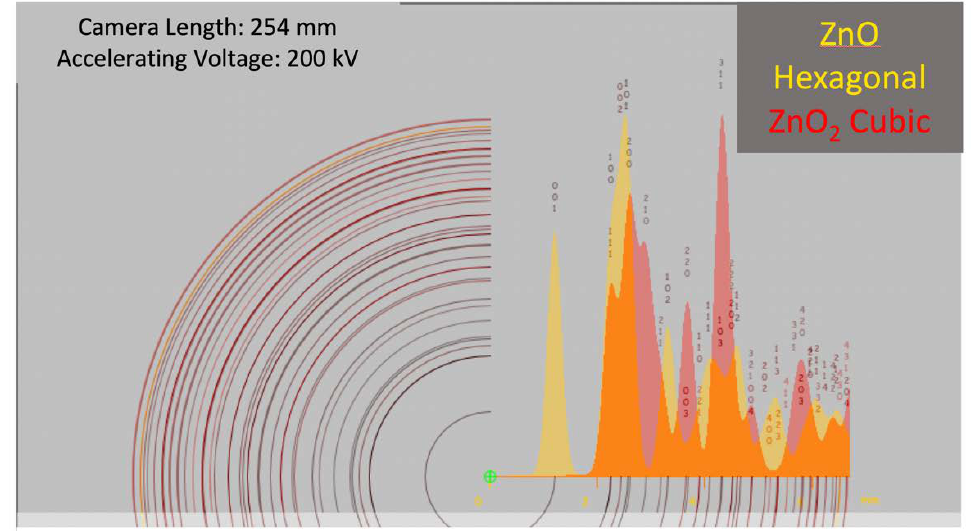
Figure 11. Theoretical comparison between electron diffraction of zinc oxides.